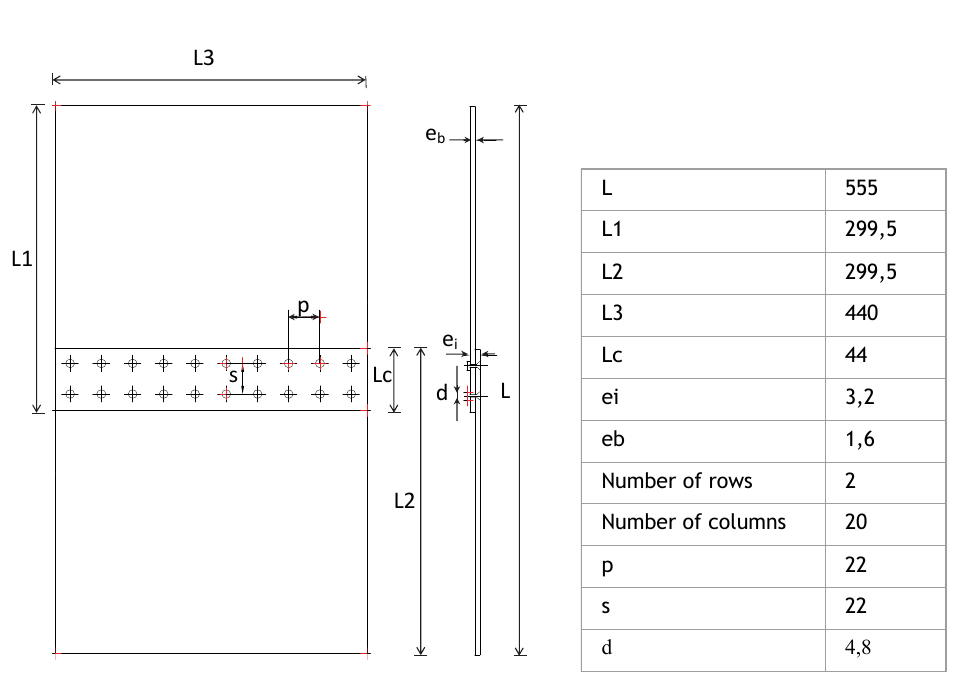
Figure 1: Specimen geometry.